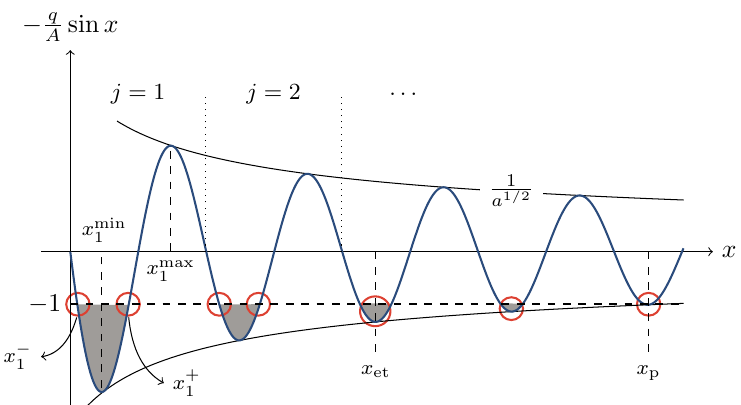
(cid:0) (cid:1) 1 + λ q sin x . Time A